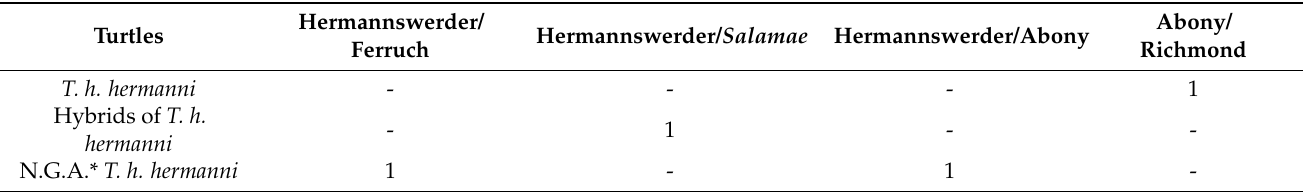
Table 5. Different combination of Salmonella serotypes in T. h. hermanni